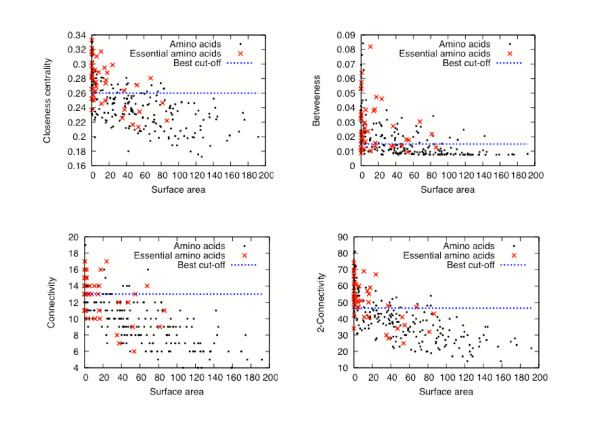
Relationship between some network-based centrality measurements and the surface area for TEM1 beta-lactamase. For each amino acid of TEM1 beta-lactamase (1BTL), we plot four network centrality measurements (closeness centrality, betweenness, connectivity and 2-connectivity) versus the surface area. The "best cut-off curve corresponds to the cut-off that minimizes the dist(centr. meas., cut-off) error. In other words, for the four centrality measurements, the best result is obtained by predicting an amino acid to be critical if it is above this line (the corresponding set of predicted amino minimizes the error dist(centr. meas.,cut-off)).